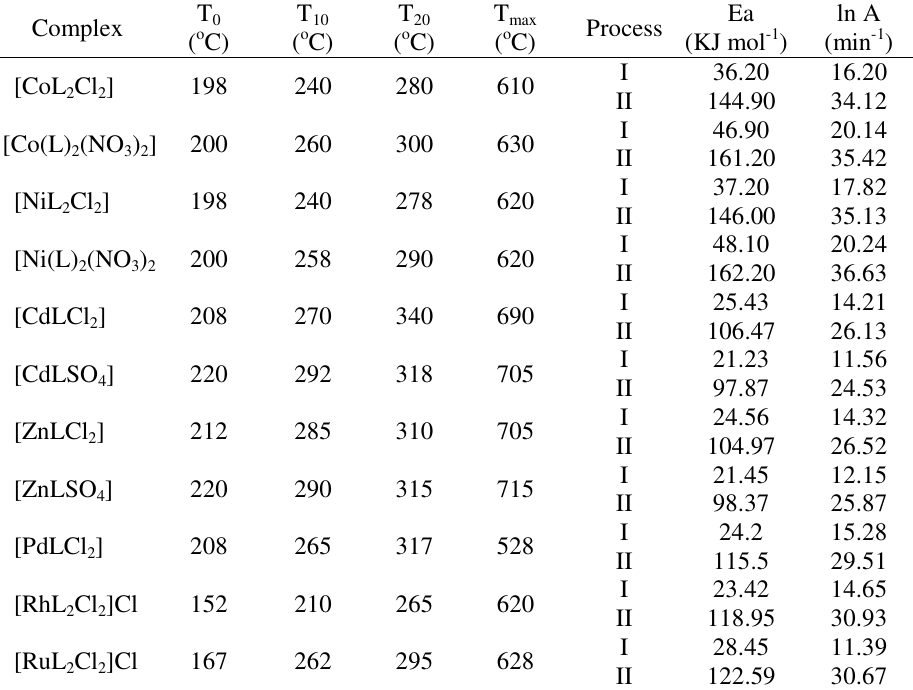
Table 4. Temperature characteristics, activation energies and frequency factors of decomposition process of